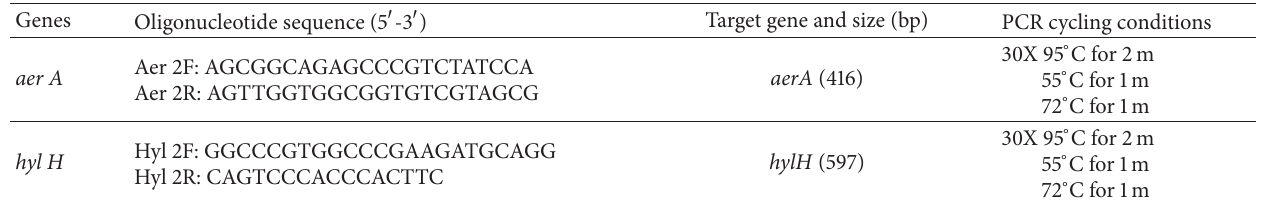
Table 2: Oligonucleotide primers that were used to detect virulence genes in Aeromonas species.